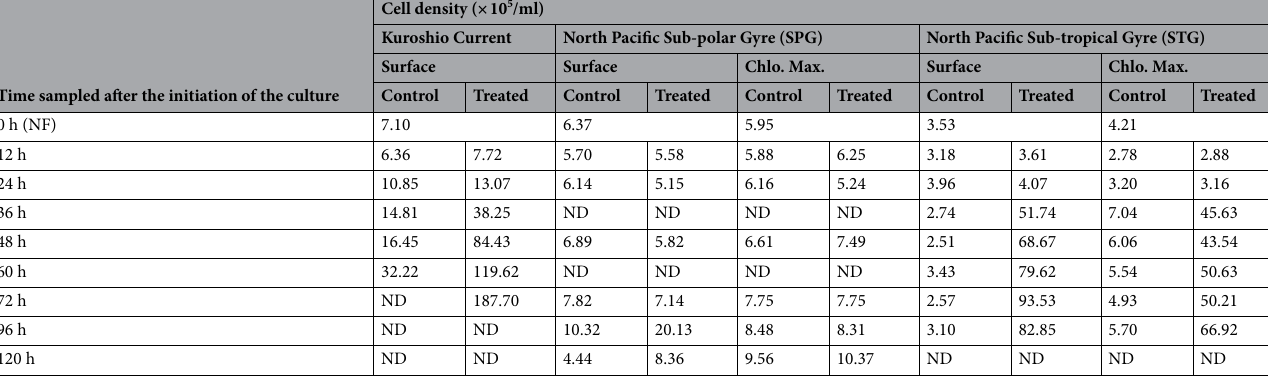
Table 2. Changes of cell density during the shipboard microcosm experiments with the water collected from Kuroshio Current, North Pacific Sub-polar Gyre (SPG), and North Pacific Sub-tropical Gyre (STG) in western North Pacific Ocean during the KH-14-2 cruise in May–June 2014. Chlo. Max. chlorophyll- a maximum, NF not filtrated, ND no data.